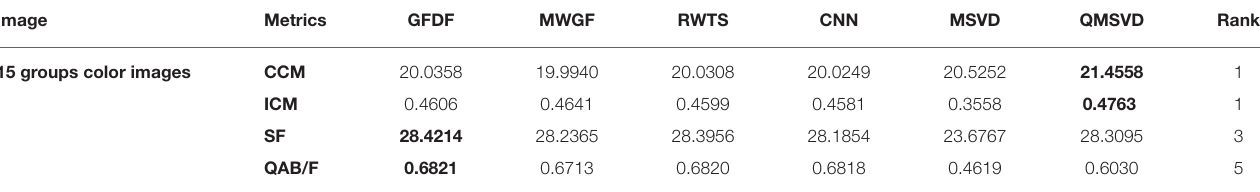
TABLE 5 | Average objective evaluation metrics of different methods on 15 groups color